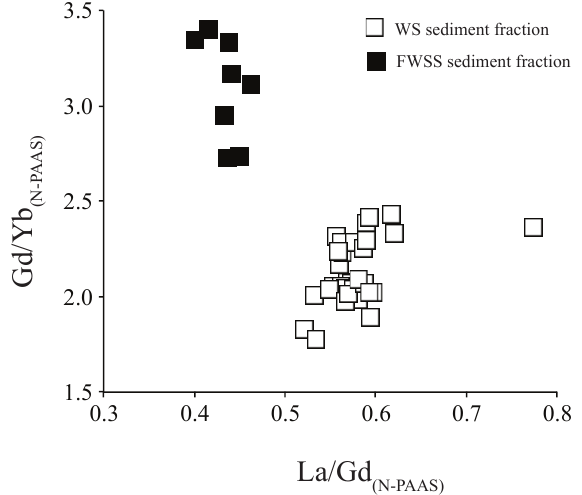
Fig. 4. Features of shale-normalised REE patterns allowing for dis- criminating between WS and FWSS sediment fractions recognised Figure 4 – Features of shale-normalised REE patterns allowing to discriminate between WS and 623 in terms of La/Gd vs. Gd/Yb normalised FWSS sediment fractions recognised in terms of La/Gd vs. Gd/Yb normalised ratios. 624